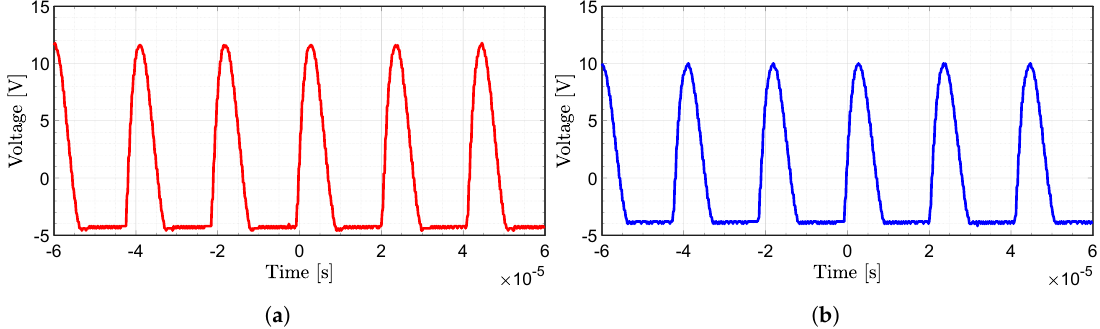
Figure 13. ( a ) Primary voltage waveform of the forward converter circuit; ( b ) secondary voltage waveform of the forward